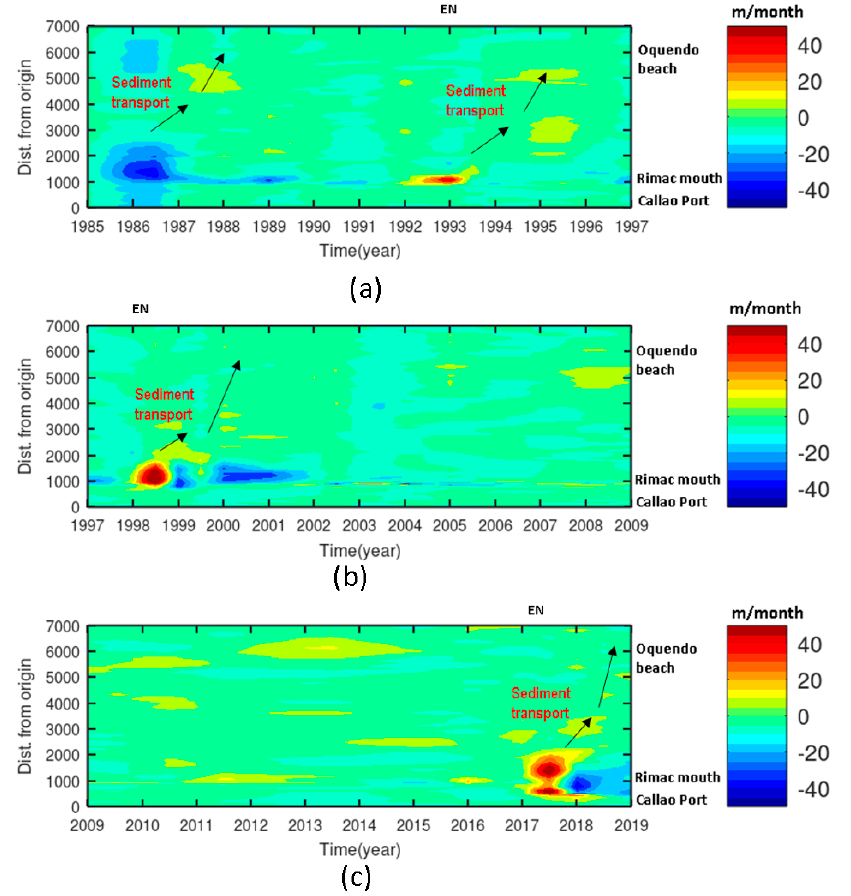
Figure 13. Detailed temporal and space evolution of the Callao Bay shoreline for EN events. Figure shows the shoreline variation-rate. a ) During EN effects in 1993, b ) During EN effects in 1997 – 1998, c ) During EN effects in 2017.